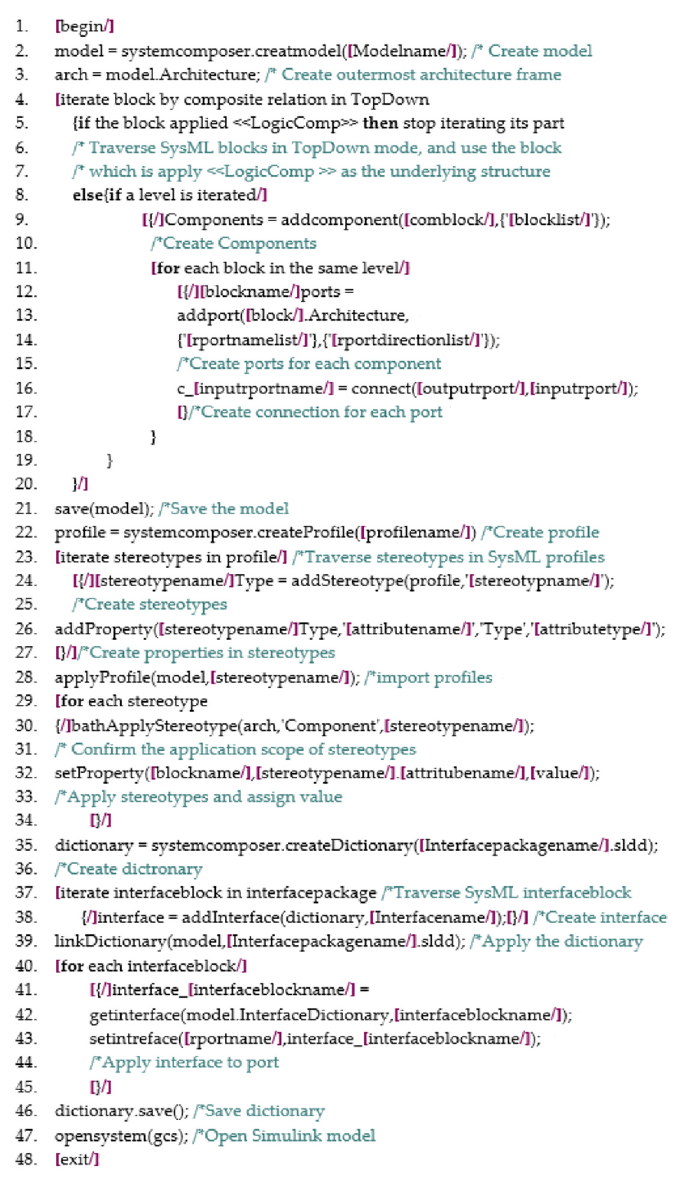
Figure 9. A part of the pseudo-modeling code.